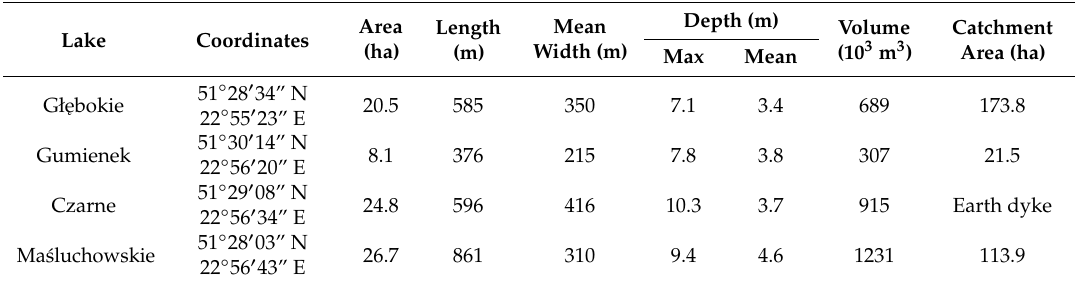
Table 1. Morphometric characteristics of the studied lakes in the West Polesie region, as described by Wilgat et al.